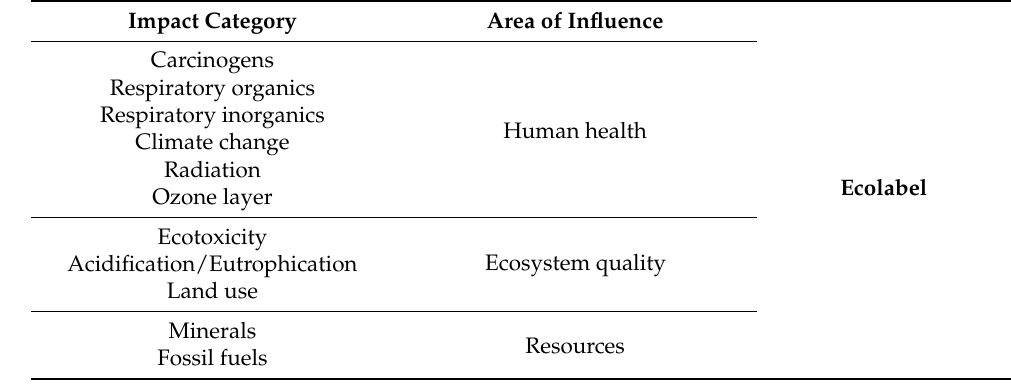
Table 1. Aggregation of data in the Eco-indicator 99